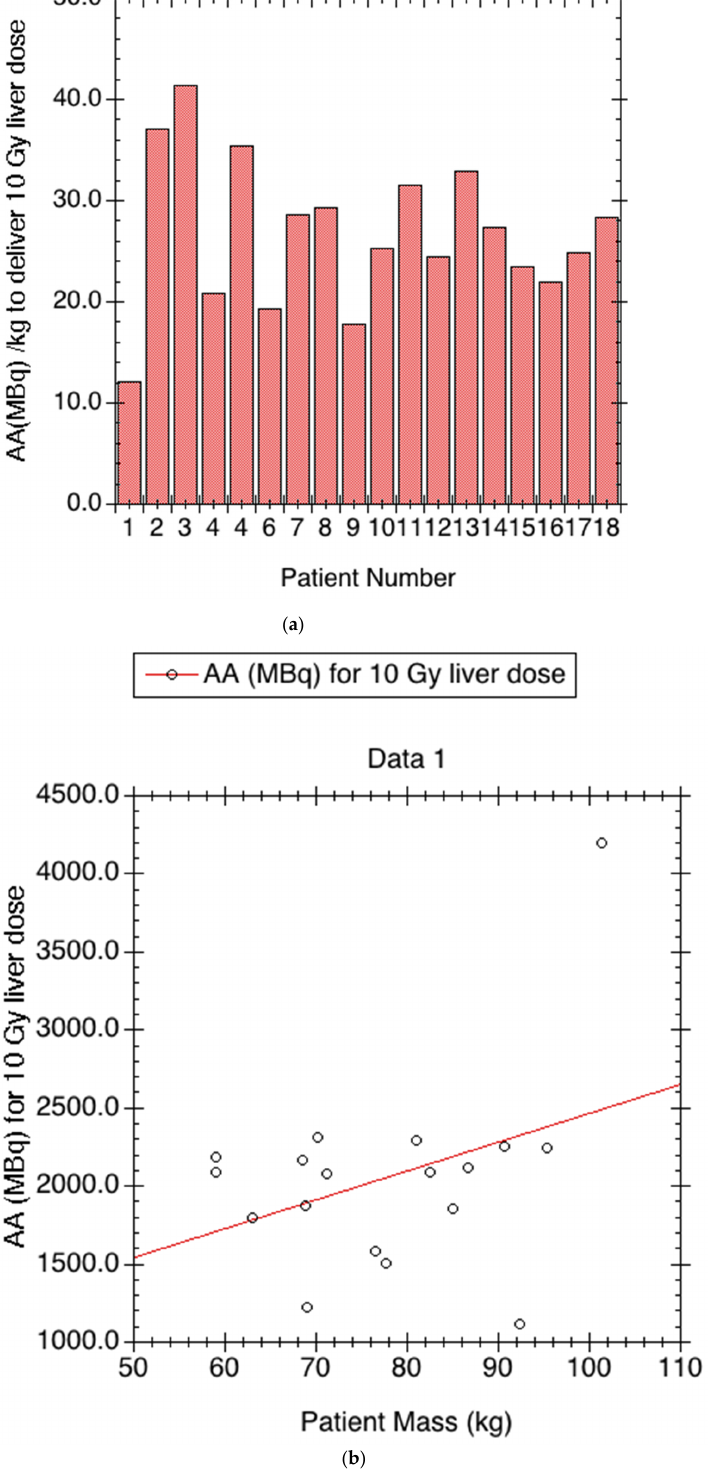
Figure 3. ( a ) Plot of activity per unit mass (MBq/kg) required to deliver 10 Gy to the liver using 90 Y ibritumomab tiuxetan by patient number. Note that there is an approximately 3.5-fold variability between the highest and lowest required activities of 90 Y/kg. ( b ) Plot of administered activity to deliver 10 Gy to the liver vs. body mass. Note there is only a modest (r = 0.37) correlation between these values, supporting the need for patient-specific dosimetry beyond adjusting the dose for patient weight.